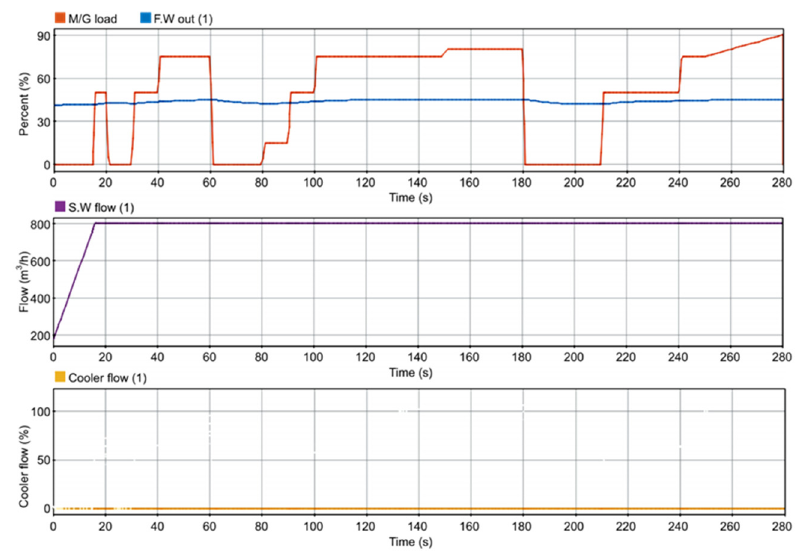
Figure 9. Actual condition of central cooling system.